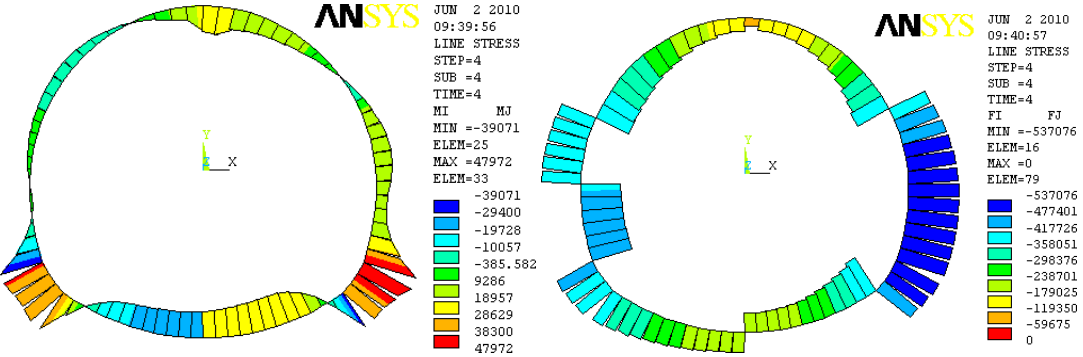
Fig. 9 Supporting axial force and supporting bending moment (/N ·